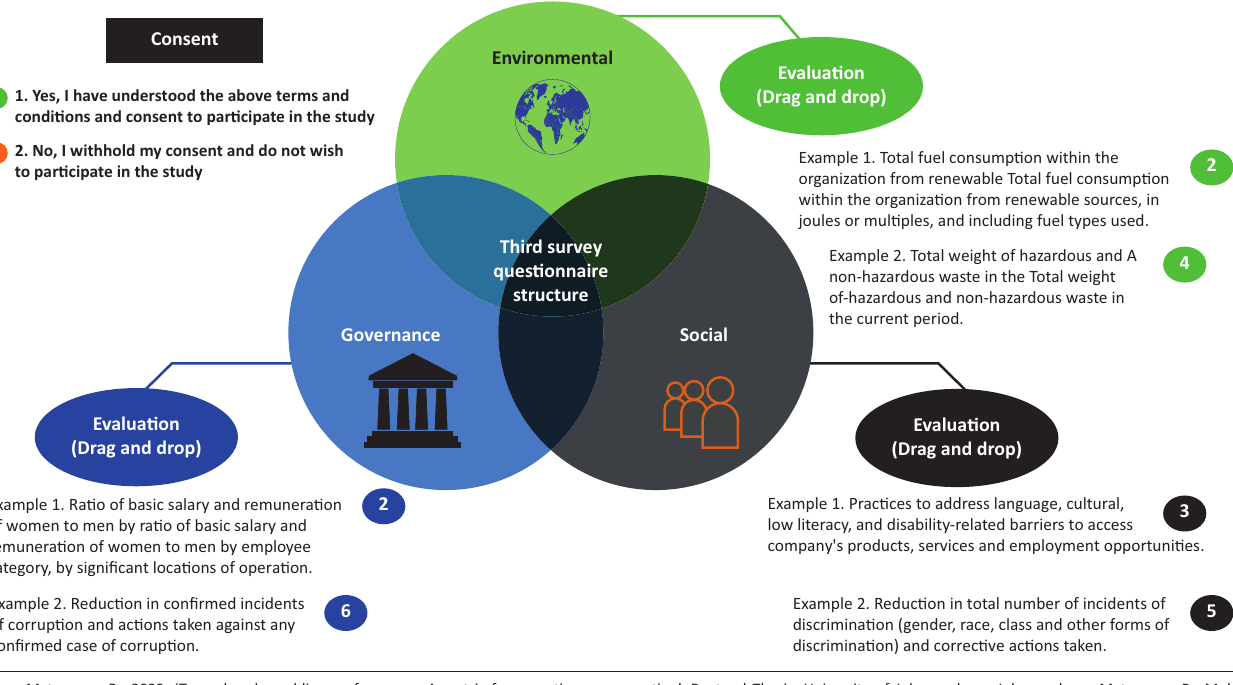
FIGURE 3: Pick, group and rank – third round